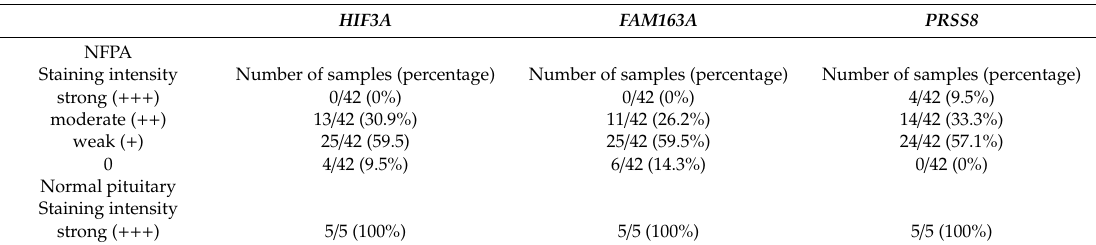
Table 1. Results of immunostaining intensity in gonadotroph NFPAs and normal pituitary.